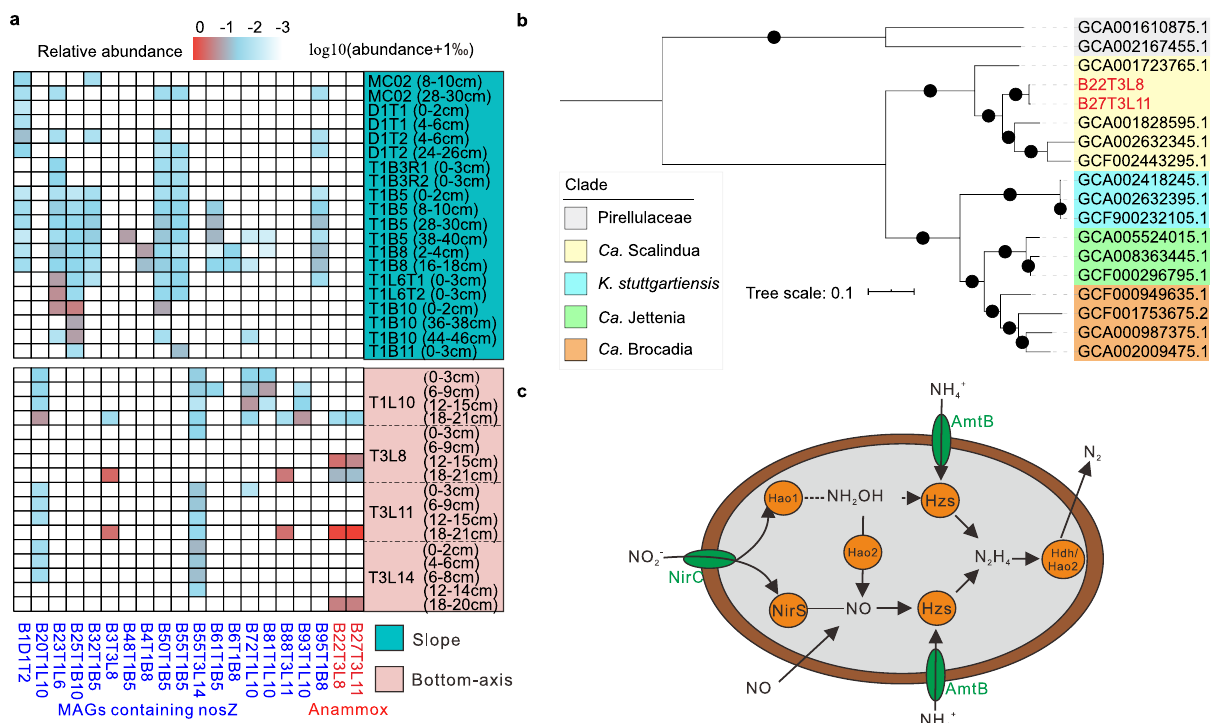
Fig. 4 Identi fi cation of potential microbial nitrogen releasers in CD. a Heatmap of the relative abundance of MAGs involved in anaerobic ammonia oxidation (anammox) and denitri fi cation in sediments from the slope and bottom-axis sites. The relative abundance of each MAG was transformed using the logarithmic scale of 10 (log10(abundance + 1 ‰ )) and was estimated using CoverM. b Phylogenomic analyses of 40 concatenated conserved proteins identi fi ed in anammox bacteria. Bootstrap values (1000 replicates) ≥ 80% are indicated by dots on branches. c Hypothetical nitrogen release in CD sediments via anammox. The anammox genes presented are from the CD bottom-axis sediment MAGs. Source data are provided as a Source data fi